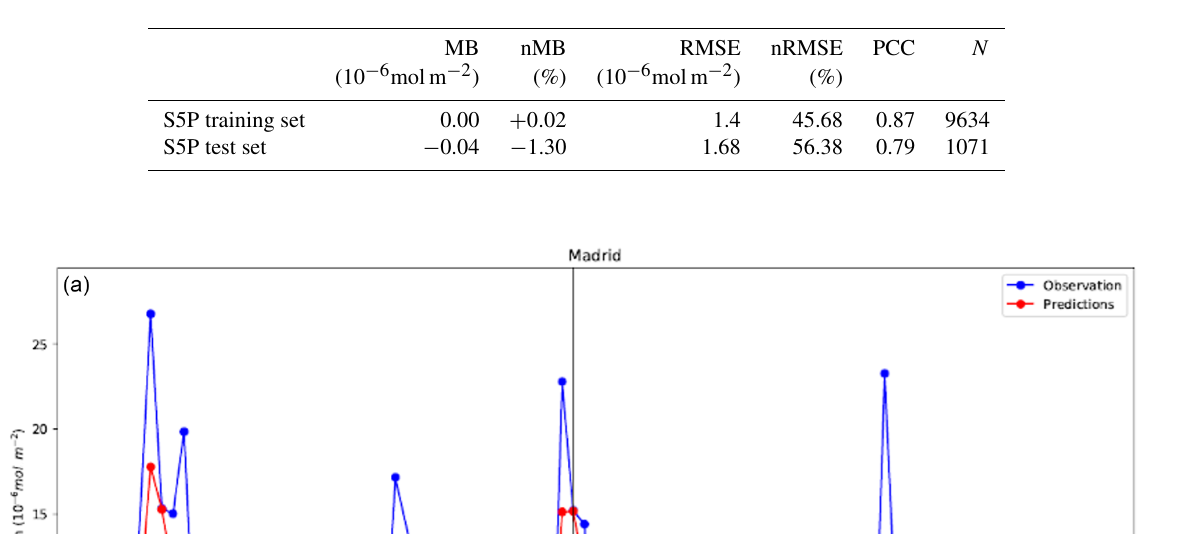
Table 1. Performance of the machine learning simulations of NO 2 tropospheric columns over all European urban areas included in the dataset. The training set and testing set cover January–May 2019 and are randomly sampled (90% and 10%, respectively) over that period. Shown are the mean bias (MB), normalized mean bias (nMB), root mean square error (RMSE), normalized root mean square error (nRMSE), Pearson correlation coefficient (PCC), and the number of data points ( N ).